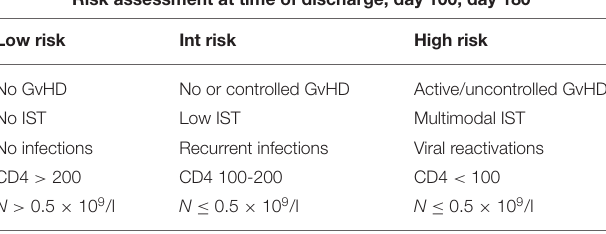
TABLE 3 | Risk grouping following discharge from allogeneic hematopoietic cell transplantation in childhood or adolescence. Risk assessment at time of discharge, day 100, day